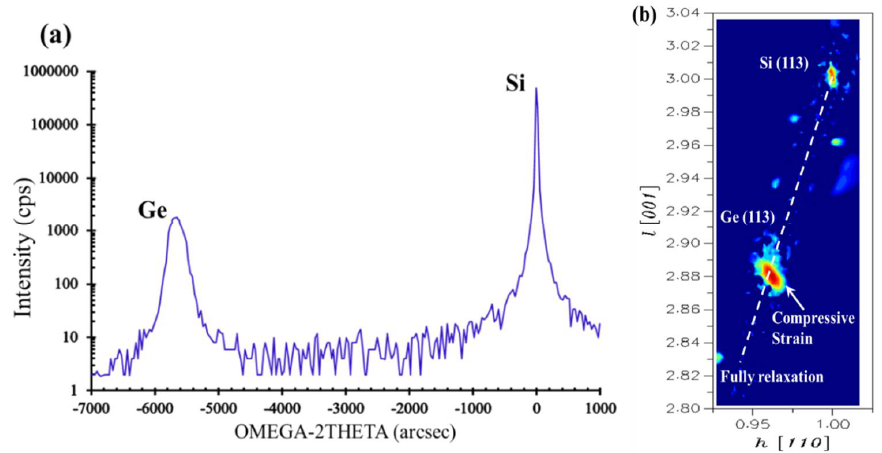
Figure 11. ( a ) HRXRD rocking curves (RCs) around (004) reflection and ( b ) HRRLMs around (113) reflection for the selectively grown Ge.